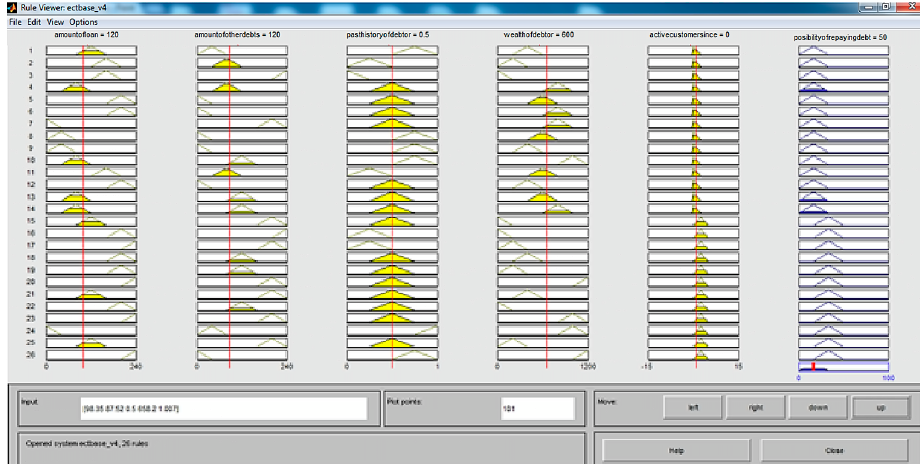
Figure 4. Fuzzy rule sets for credit debts from Matlab